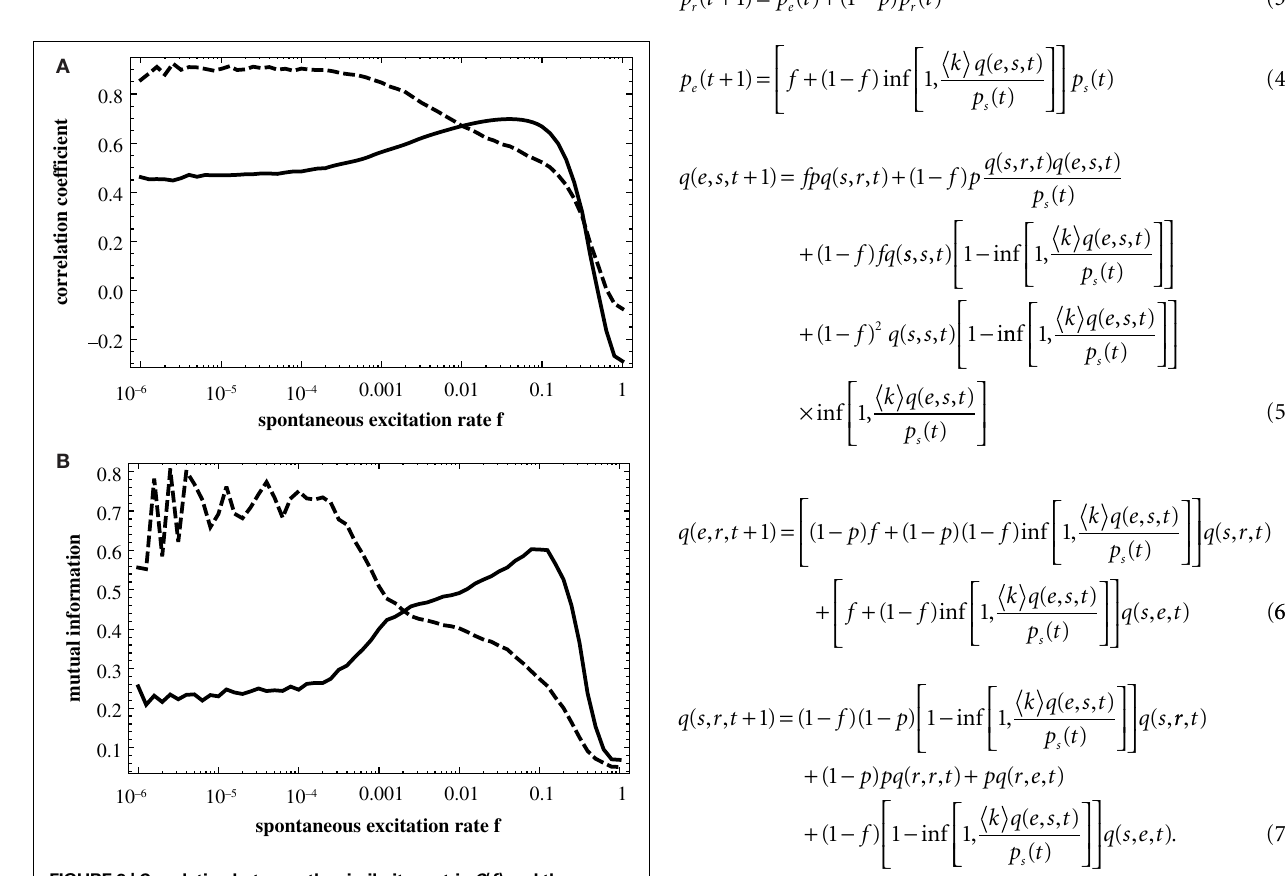
FIGURE 3 | Correlation between the similarity matrix C ( f ) and the topological matrices T (full curve) and D (dashed curve) as a function of f for the hierarchical graph with N = 256 nodes. The correlation is measured (A) by the correlation coeffi cient of the two matrices, Eq. 2, and (B) by the mutual information, Eq.